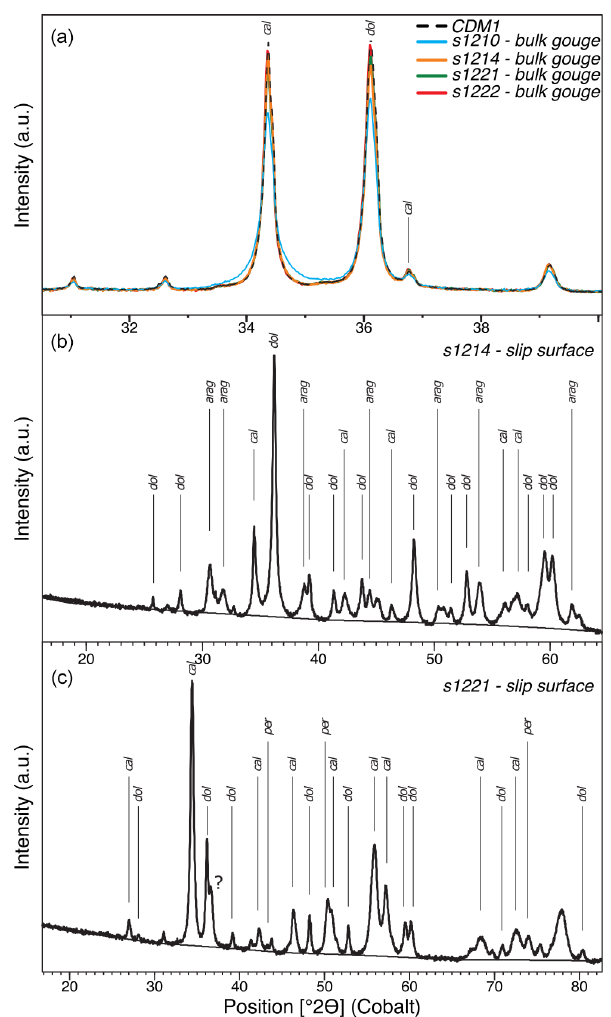
Figure 6. XRPD analysis of bulk gouge and slip surfaces. (a) Bulk gouge shows a Lorentzian profile for the main calcite peak in exper- iment s1210, suggesting either a large crystallite size distribution or microstrain as a result of intense comminution involving a large fraction of the gouge. (b) At 30µms − 1 in water-dampened condi- tions, traces of aragonite are found on the slip surface as a result of calcite polymorphic transformation during prolonged mechani- cal grinding. (c) For s1221 (1ms − 1 in room-humidity conditions), presence of Mg calcite and periclase (MgO) on the mirror-like slip surface is observed due to decarbonation of